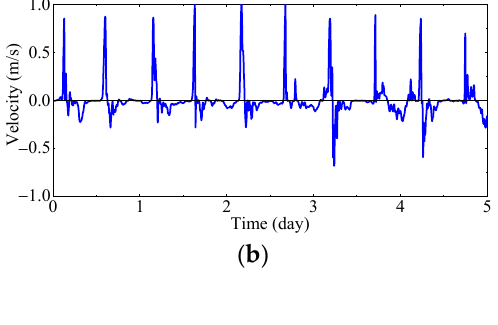
Figure 8. Velocity profiles for internal wave shoaling on the continental slope, ( a ) X = 257,805 m; ( b ) X = 175,984 m; ( c ) X = 161,766 m; ( d ) X = 156,534 m; ( e ) X = 148,723 m; ( f ) X = 140,036 m; ( g ) X = 123,135 m; ( h ) X = 100,064 m; ( i ) X = 79,943 m; ( j ) X = 59,823 m; ( k ) X =39,972 m; (l) X = 16,851 m.